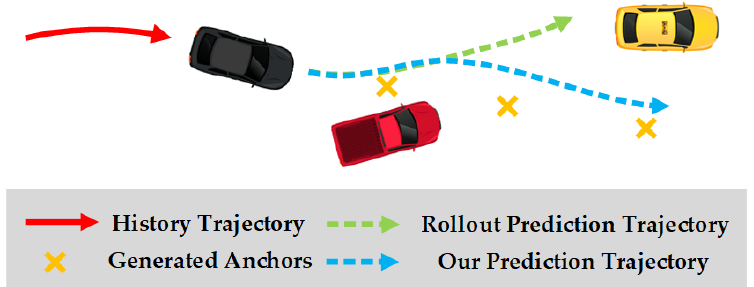
Figure 1. Overview of our work. The red line represents the history trajectory of certain object. The yellow crosses denote the generated anchors. The dotted green and blue lines represent trajecto- ries predicted by the rollout method and our proposed RRN method,